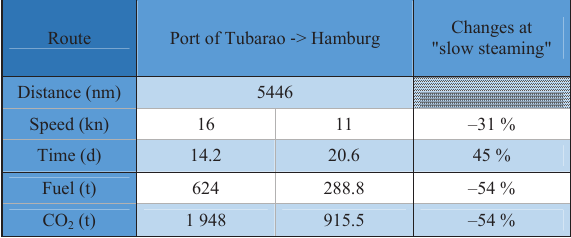
Fig. 1. Calculation of the transition by the “Slow steaming” method and without